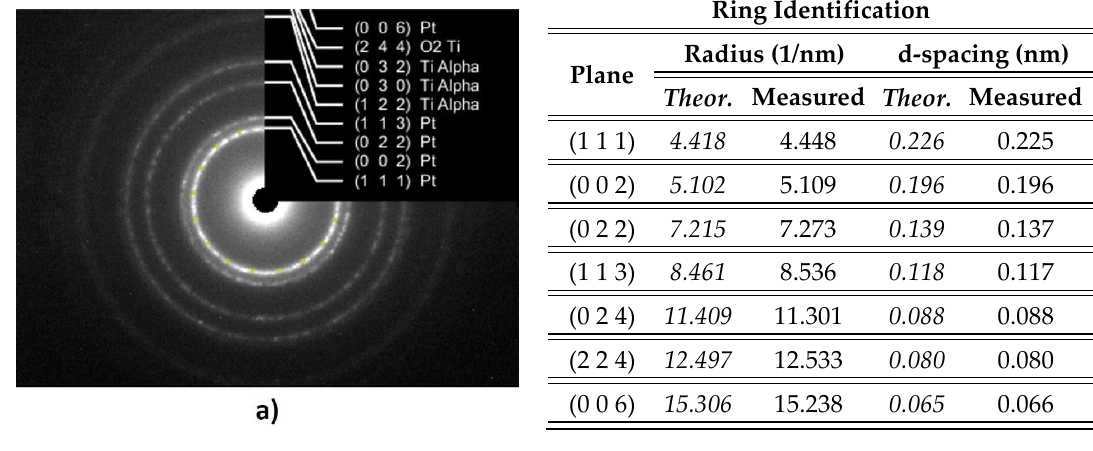
Figure 11. SAED investigation for PtTi/Si thin films: ( a ) Indexed SAED patterns of PtTi/Si. Inset shows Miller indices for FCC Pt tetragonal Ti α and tetragonal TiO 2 – anatase; ( b ) Electron diffraction data.